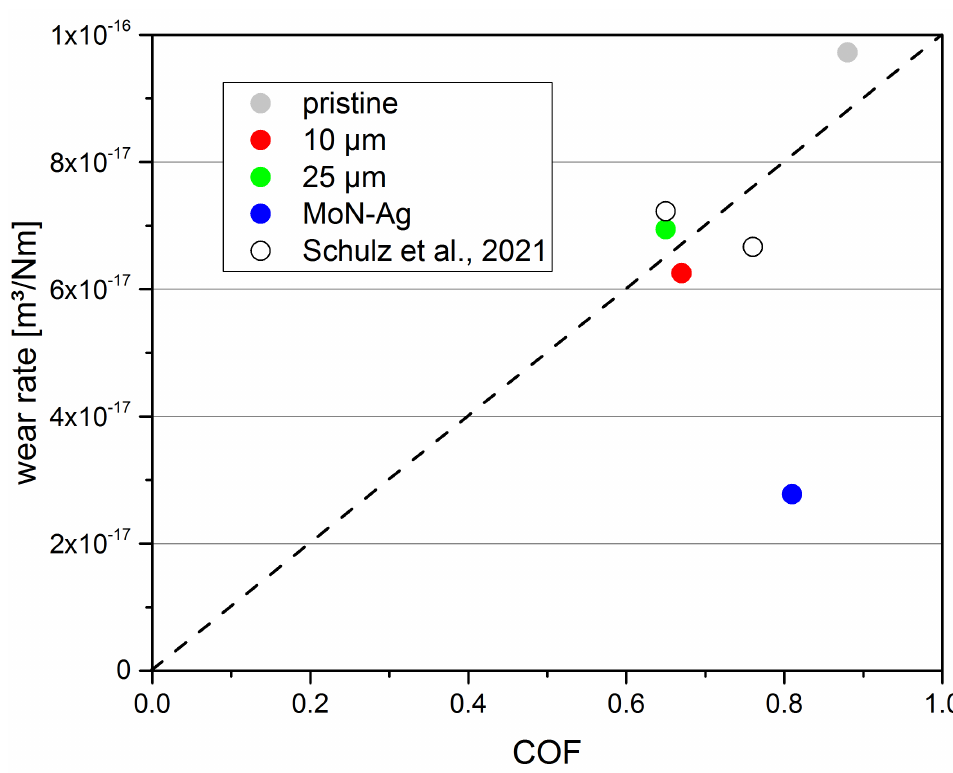
Figure 6. Calculated wear rates versus the corresponding coefficient of friction (averaged after running-in) for the surfaces presented in this work (colors) and data from Schulz et al., 2021 [16]. The dashed line refers to the model that the provided work in the testing routing is proportional to the abrasion